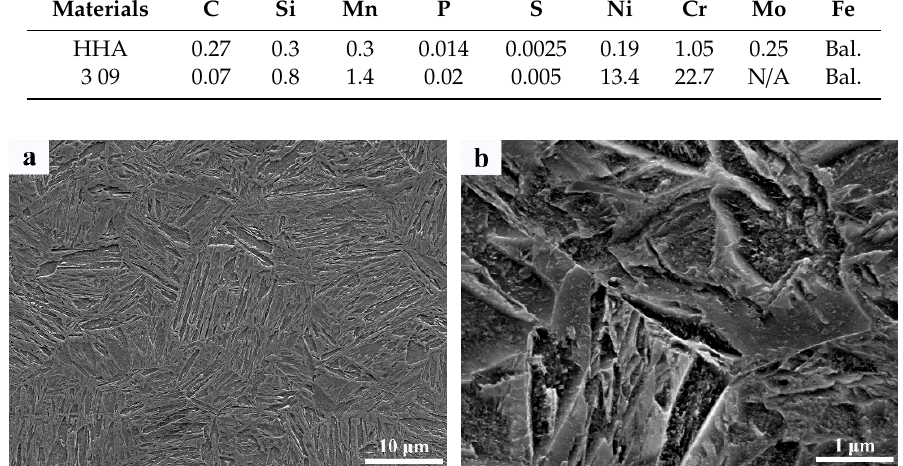
Figure 1. Microstructure of high hardness armour (HHA) base metal; ( a ) low magnification of scanning electron microscope (SEM); and ( b ) high magnification of SEM.